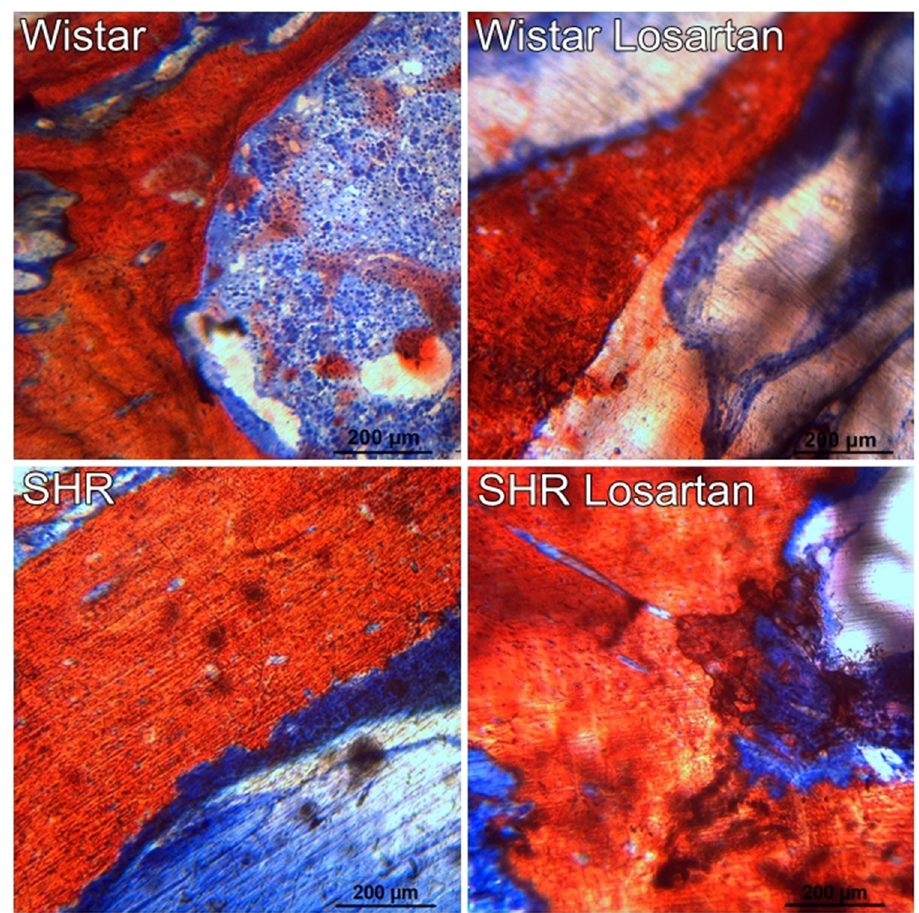
Figure 5- Histology of the maxilla. Histological images of the alveolar bone dynamics in the maxilla for Wistar, Wistar Losartan, SHR, and SHR Losartan. Presence of considerable bone was noted in the medullary compartment. All groups showed similar bone dynamics. Undecalcified thin-ground sections were prepared along the sagittal maxilla axis and Stevenel’s blue and red alizarin